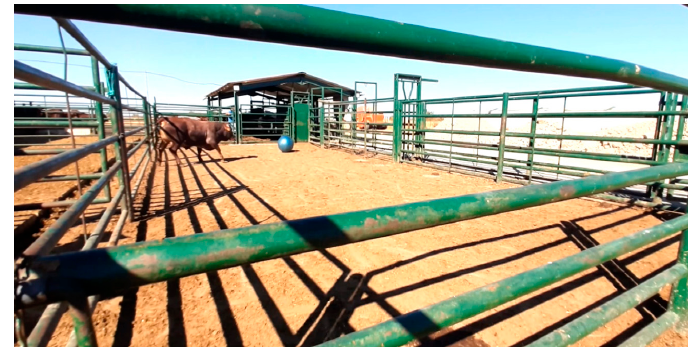
Figure 2. Novelty test with a ball.